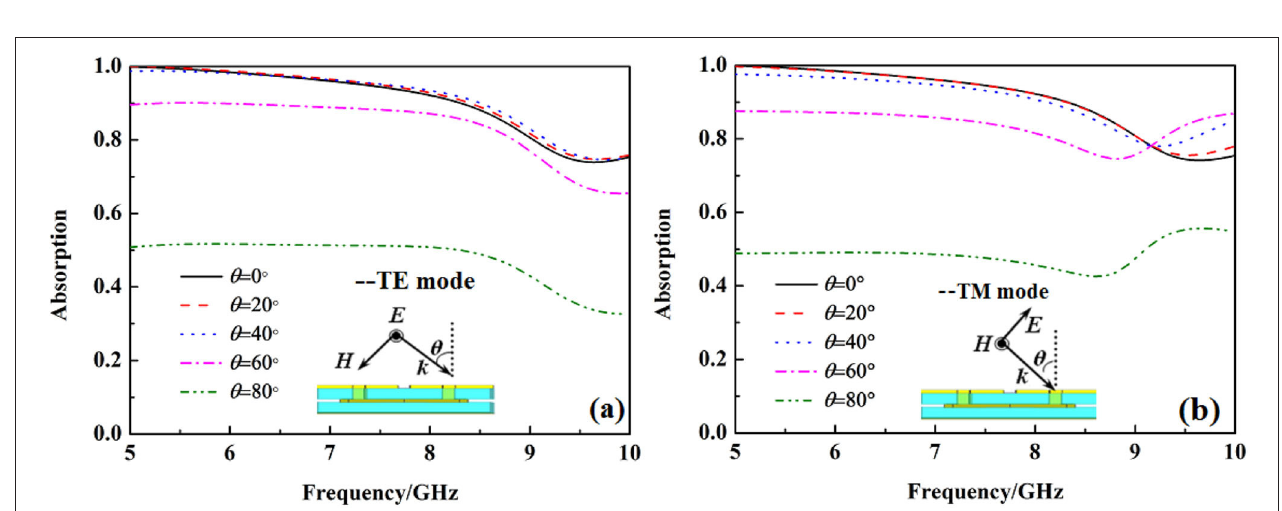
FIGURE 10 | The absorption of the metamaterial absorber under different incident angles with the Fermi level of graphene at 0.5 eV: (a) transverse electric (TE) mode, (b) transverse magnetic (TM) mode.